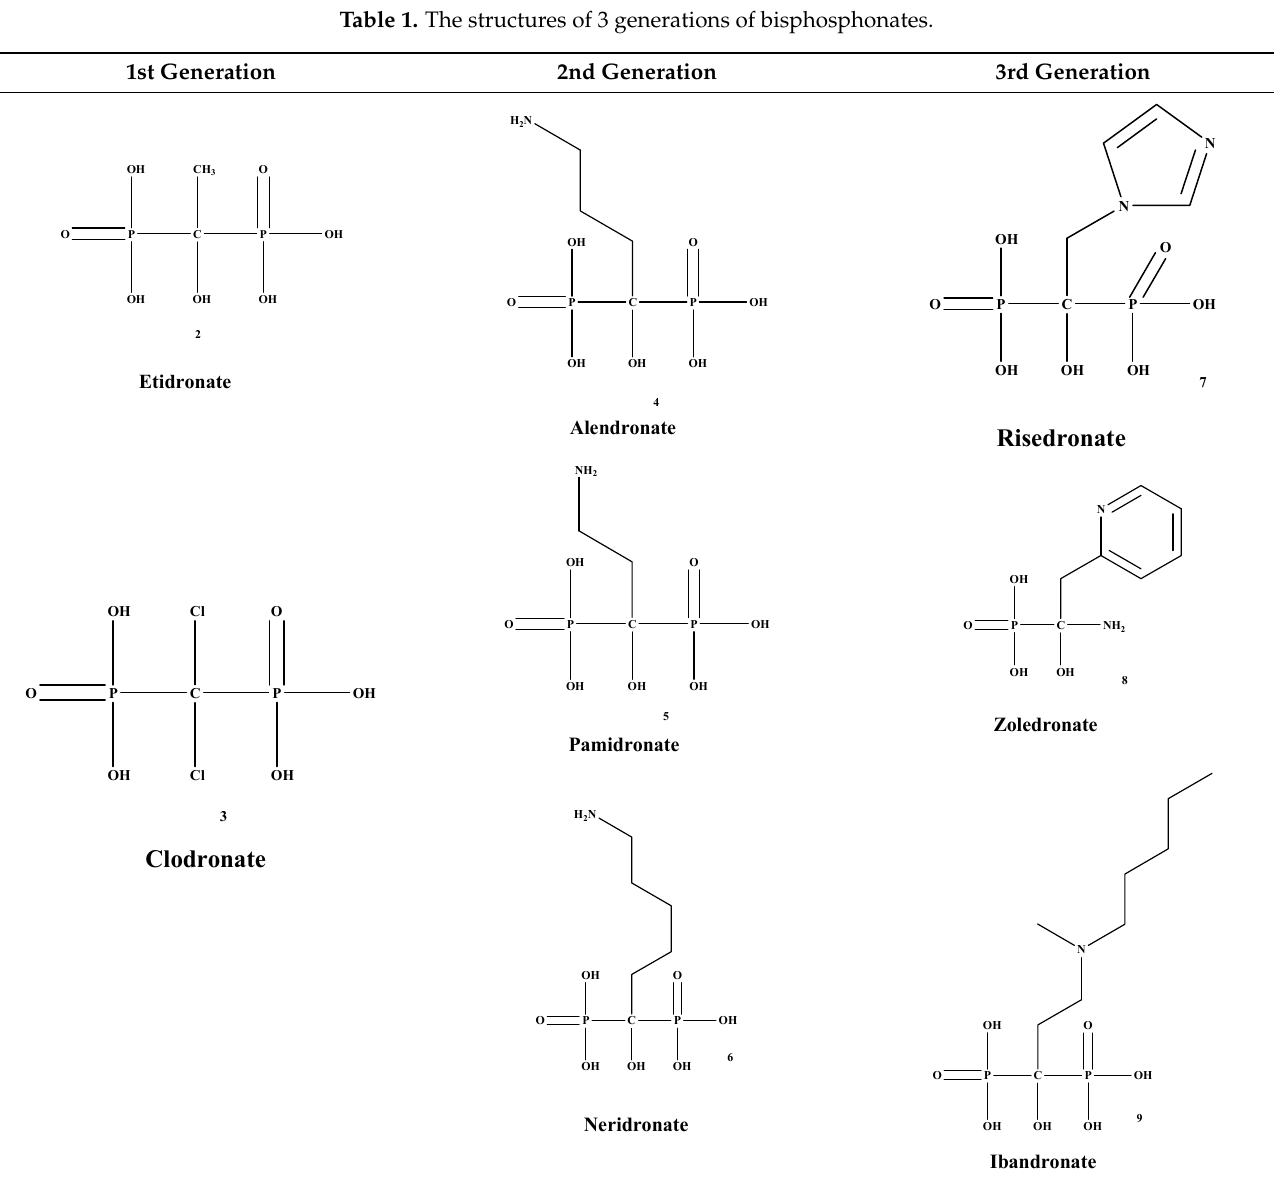
Figure 1. Structure of Bisphosphonate. Table 1. The structures of 3 generations of bisphosphonates.